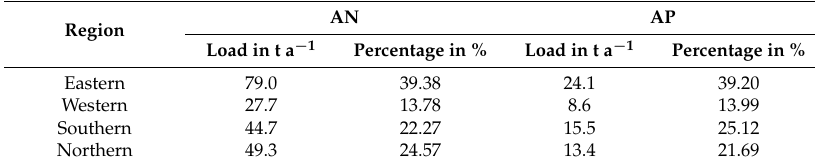
Table 5. Loads and contribution ratios of AN and AP from different regions.